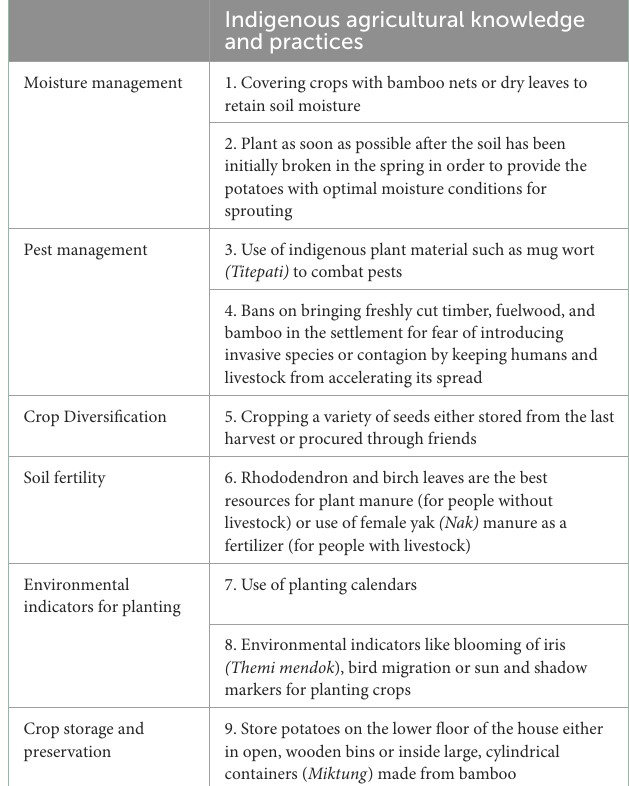
TABLE 1 List of indigenous agricultural knowledge and practices exercised in Khumbu,